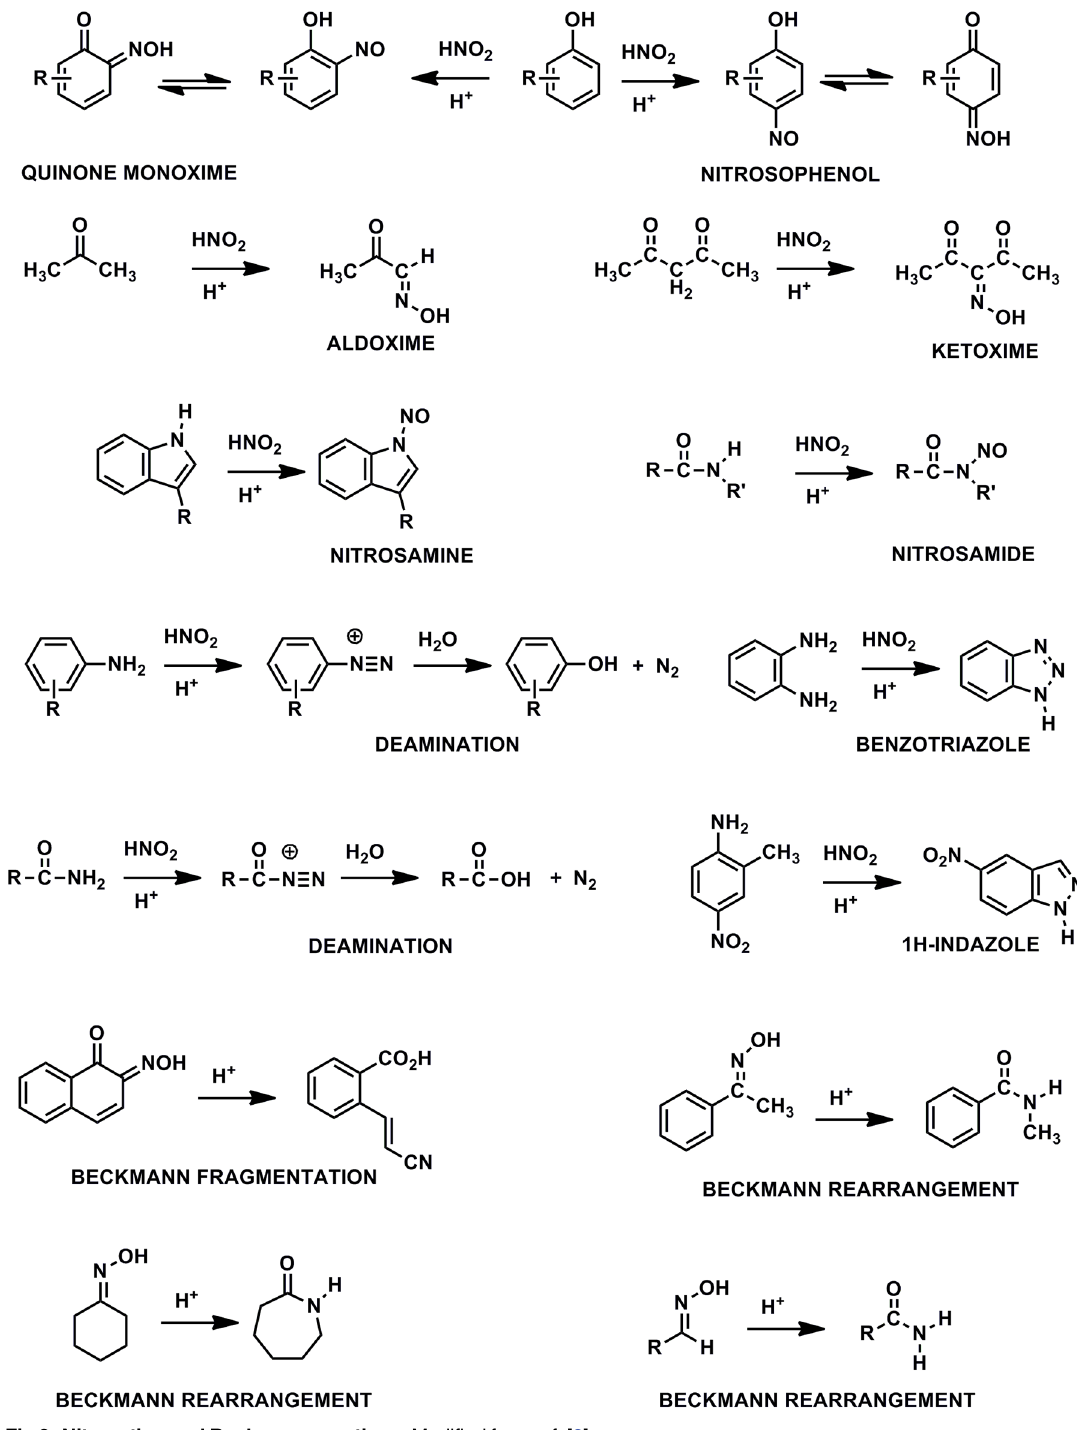
Fig 2. Nitrosation and Beckmann reactions. Modified from ref. [6].